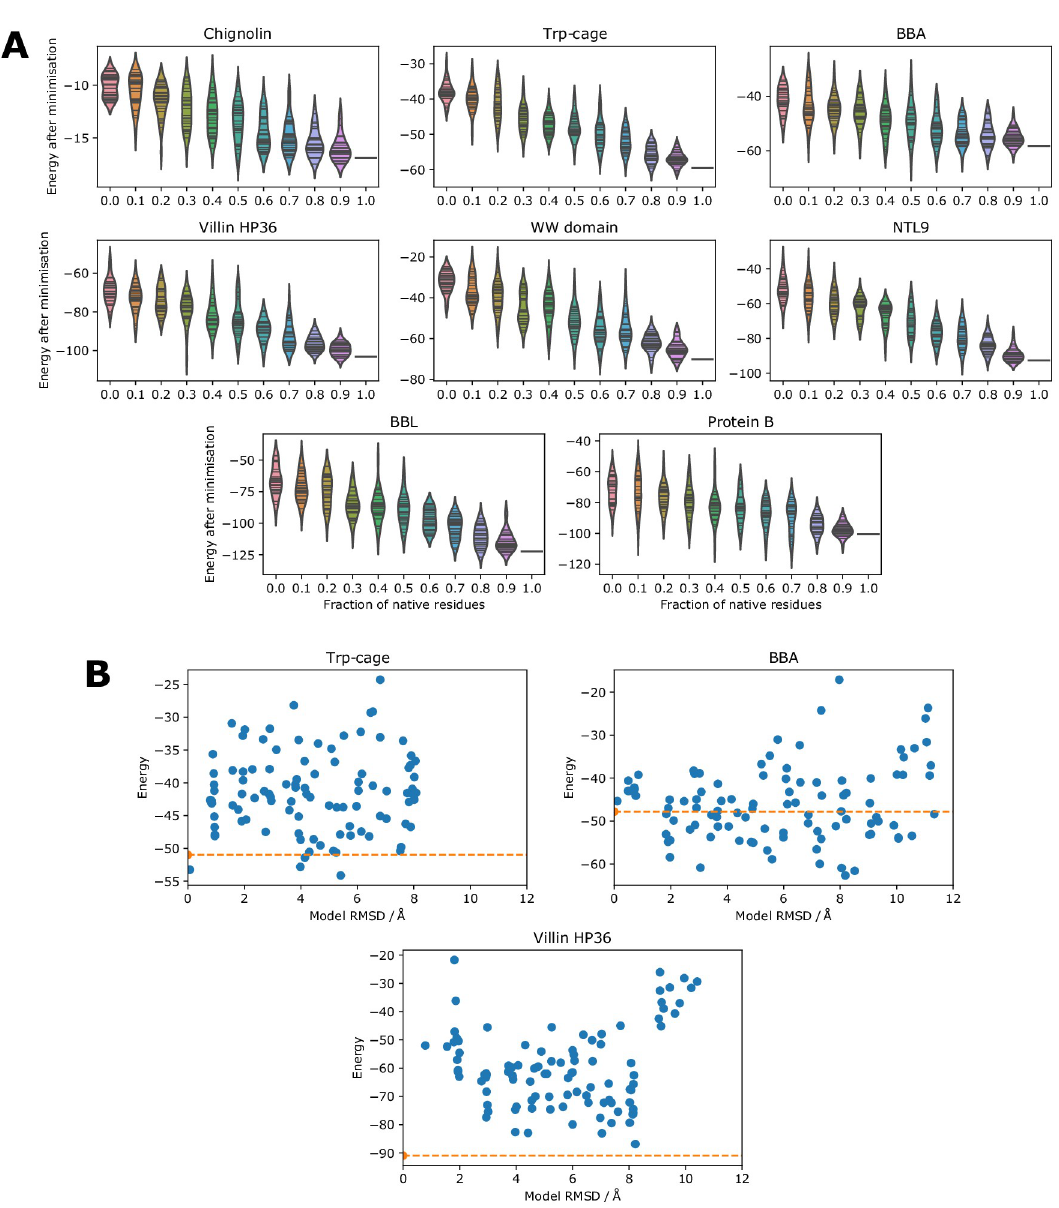
Fig 5. Protein design and model scoring. (A) The energy of sequences with varying fractions of native residues threaded onto the native structure. 30 sequences are scored for each fraction. A short minimisation of 100 steps is carried out for each sequence and the energy is recorded at the end of the minimisation. (B) The energy of well-packed decoys generated using 3DRobot is compared to the C α RMSD of the decoys (blue dots) and the energy of the native structure (orange line). Chignolin was too small to run 3DRobot on.